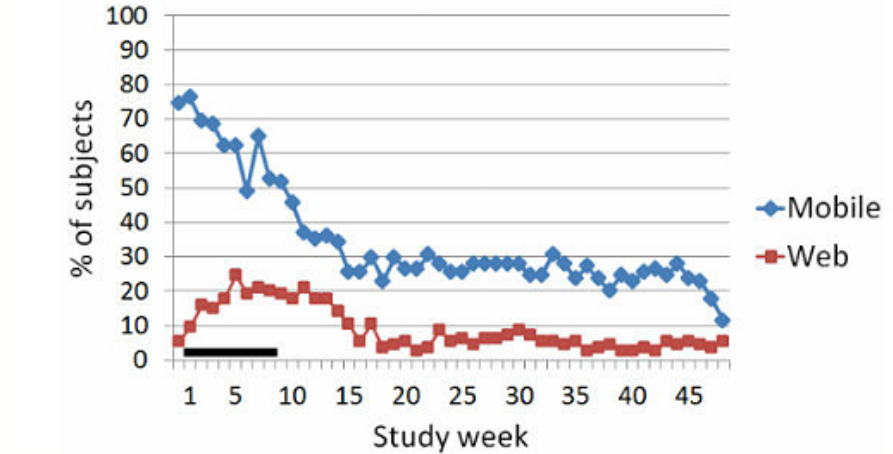
Figure 3. Percentage of subjects using Web and mobile technologies during the study (baseline period = week 0) based on usage logs. Horizontal line along the x-axis indicates active intervention